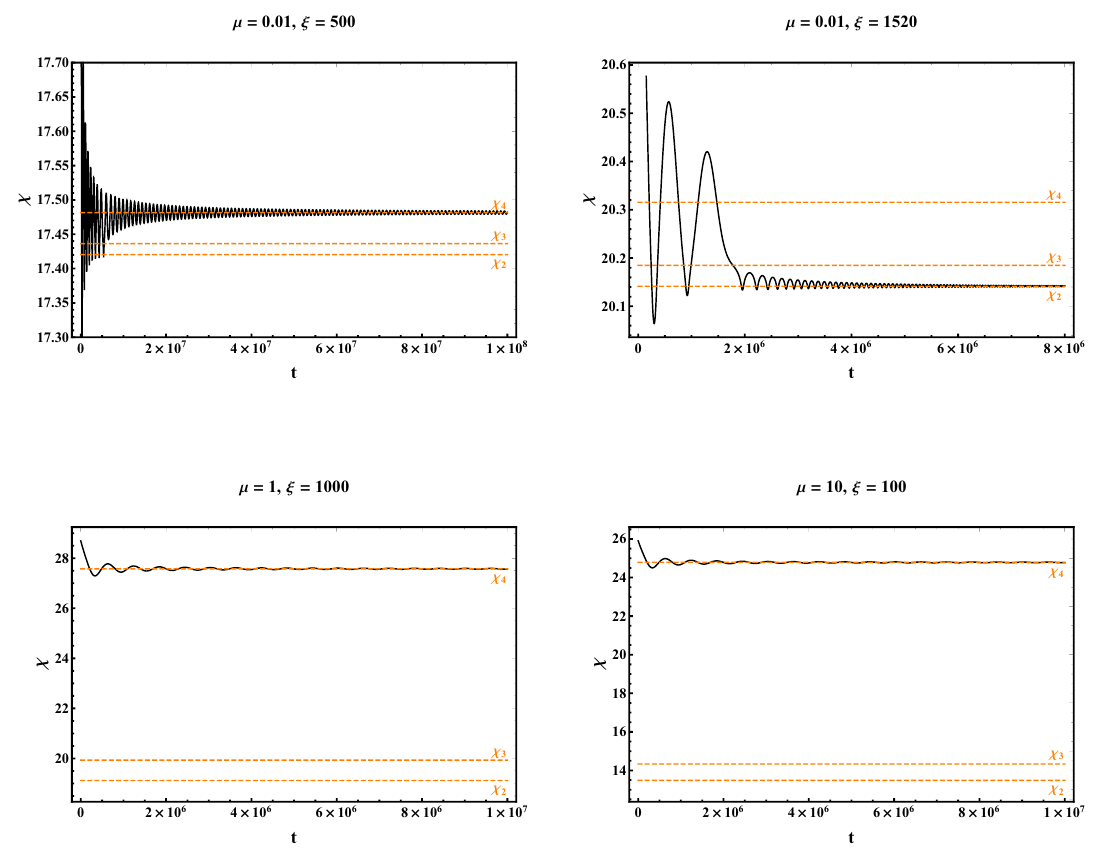
Figure 4 . The time evolution of the in(cid:13)aton (cid:12)eld in the Einstein frame, (cid:31) , for given parameters (cid:22) and (cid:24) . The orange lines in the (cid:12)gure refer to the minima placed at (cid:31) 2 and (cid:31) 4 , and also the maximum of the bump at (cid:31) 3